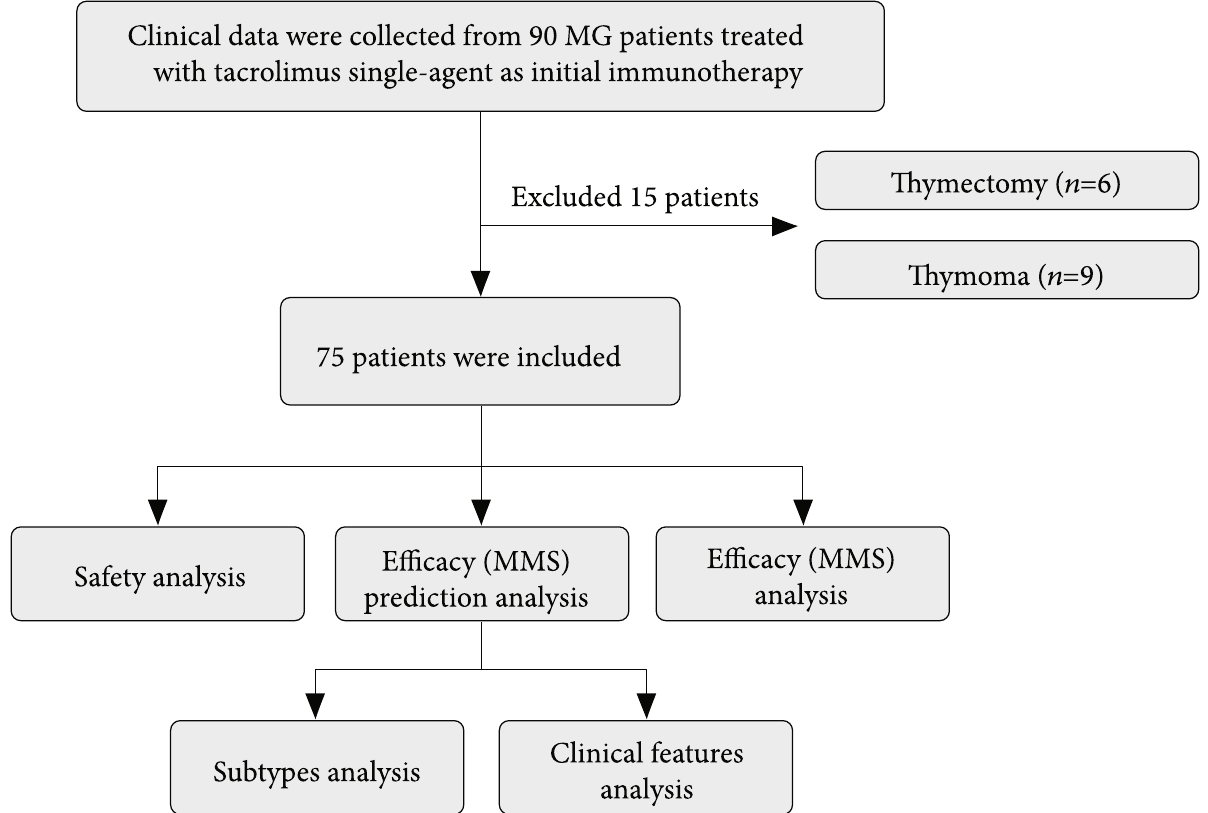
Figure 1: The fl owchart designed for the